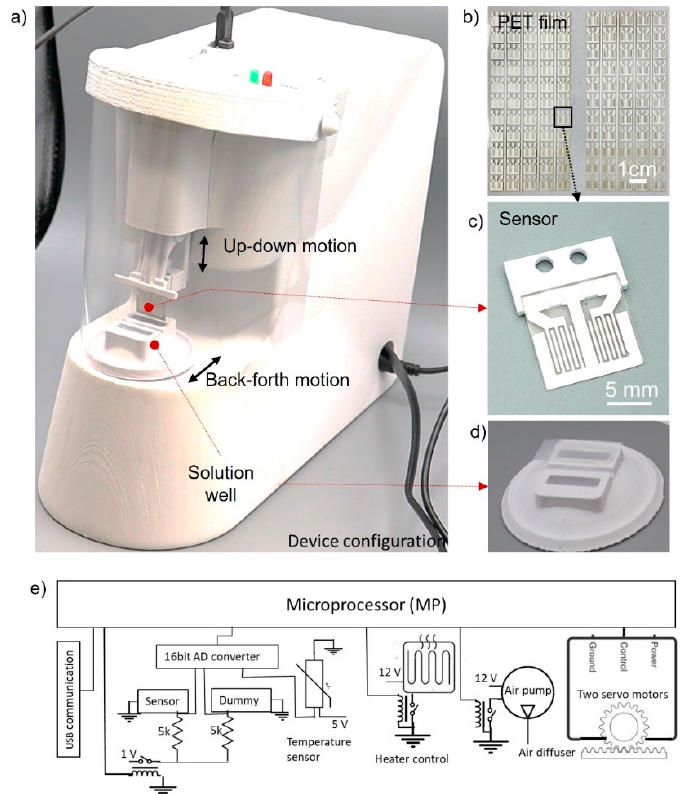
Figure 1. ( a ) Analyzer for rapid COVID-19 screening. ( b ) Sensors are made on a PET film coated with single-walled carbon nanotubes immobilized with antibodies. ( c ) A sensor consists of a SARS-CoV-2 sensor and a control sensor. ( d ) Sample cup containing 1xPBS with 1mL-target analyte and 1.1 mL-DI water. ( e ) Configuration of the electric circuit. USB communication unit, resistance measurement units, temperature sensing unit, heating and control unit, air blow with a diffuser, and two servo motors for vertical and horizontal movements.